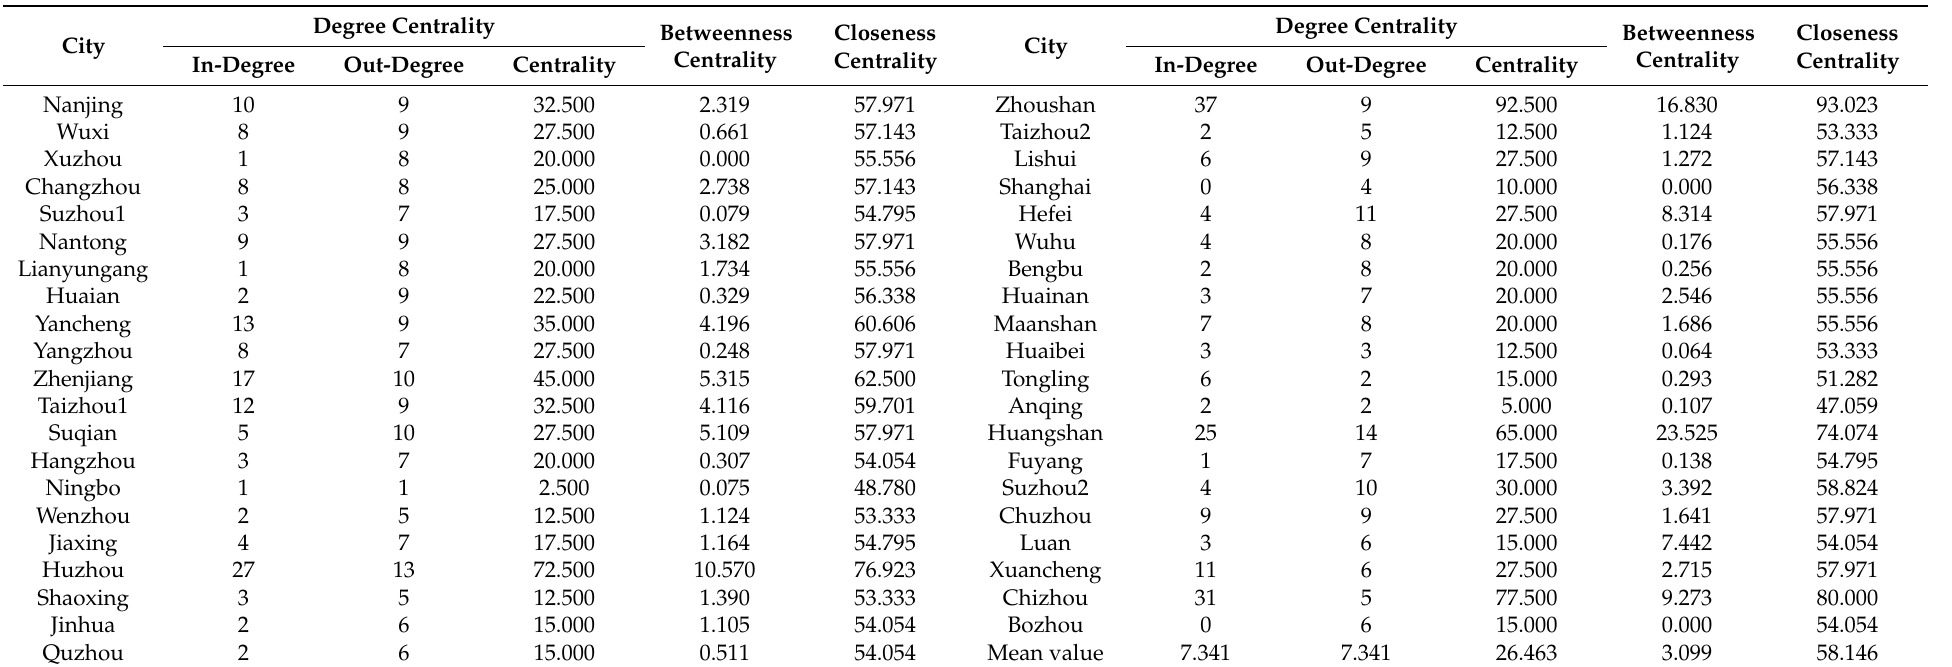
Table 4. Centrality analysis of spatial association network of tourism eco-efficiency in the Yangtze River